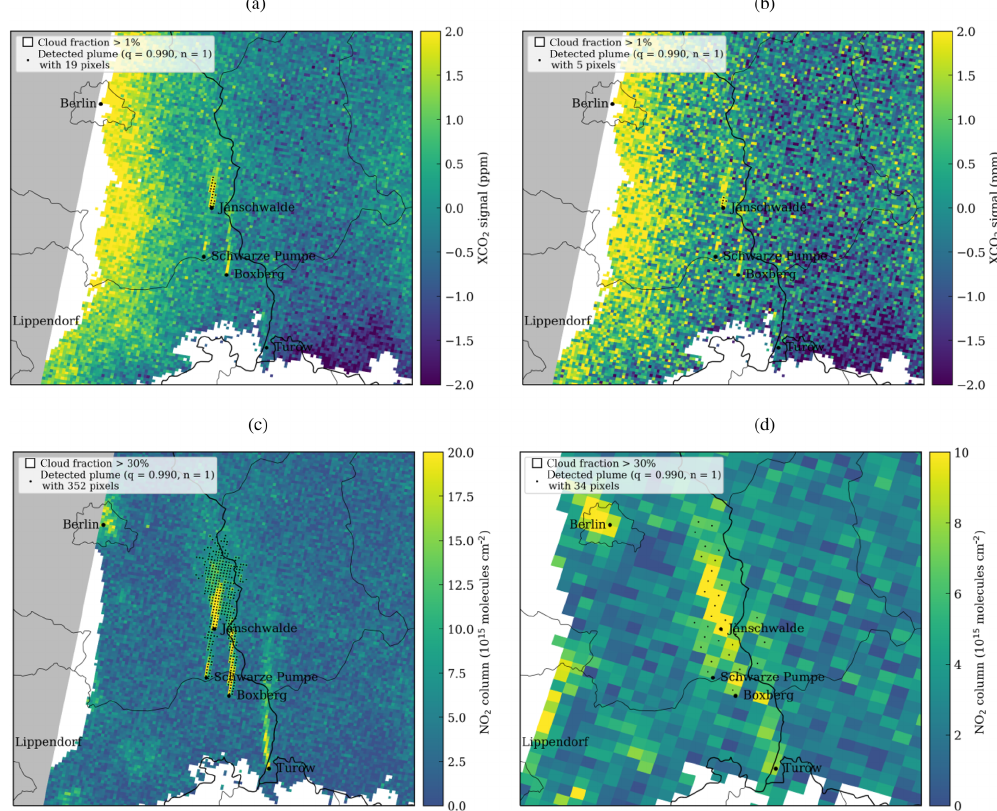
Figure 13. Example of plume detection for Jänschwalde power plant on 17 February 2015 using (a, b) the CO 2 instrument with σ VEG50 of 0.5 and 1.0ppm, (c) the NO 2 instrument with the high-noise scenario and (d) the NO 2 instrument on